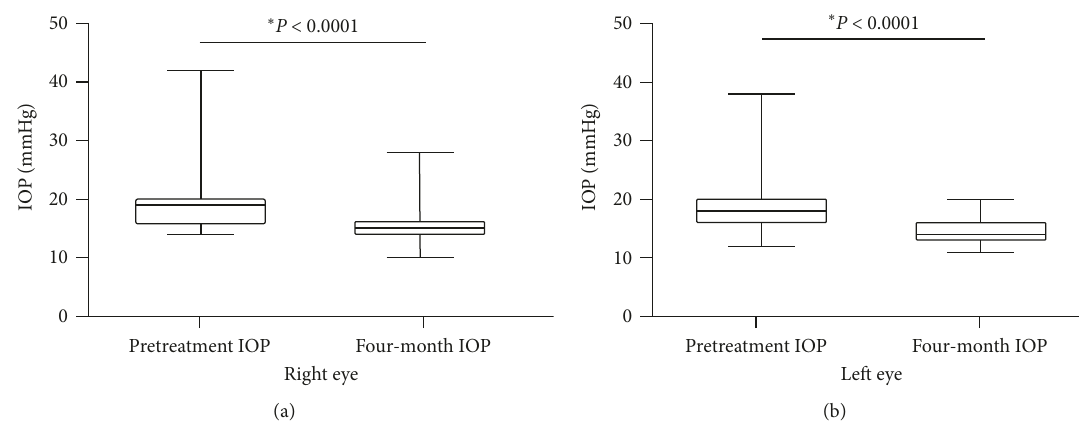
Figure 5: IOP measurements obtained from POAG patients receiving maximum tolerated medical treatment: (a) comparison between IOP values obtained before electrical stimulation to those obtained at the four-month follow-up visit for the right eye; (b) comparison between IOP values obtained before electrical stimulation to those obtained at the four-month follow-up visit for the left eye. pairs signed rank test.